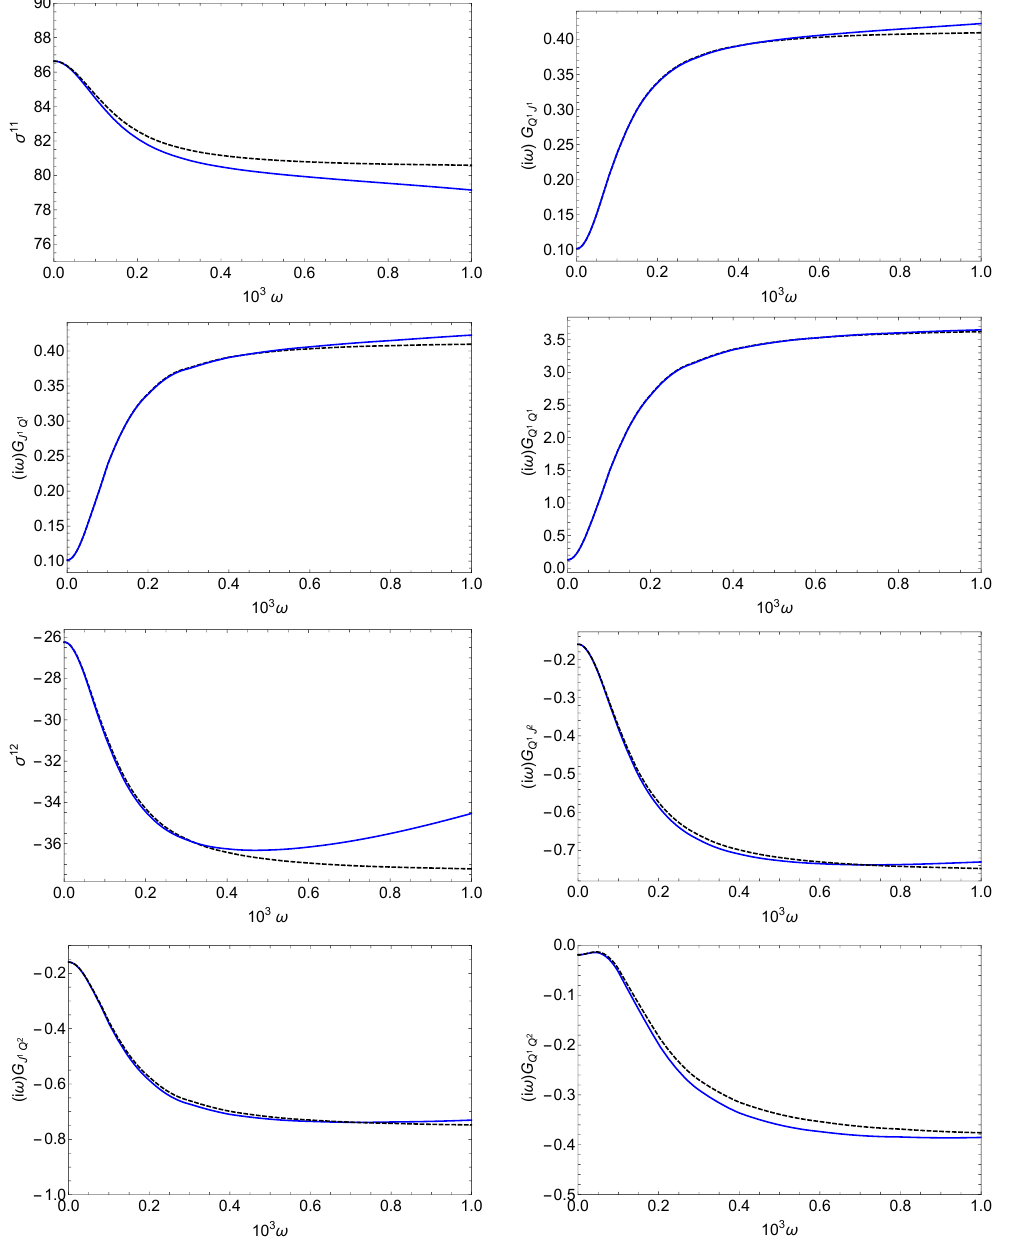
Figure 4 . Plots of the components (1 , 1) and (1 , 2) of the thermoelectric conductivities as functions of the frequency. The dashed lines correspond to the analytic formulas (3.38). Here (cid:0) (cid:1) ( φ s , ψ s , T, µ, k, k s , γ, δ, B ) = 10 − 4 , 4 , 1 , 1 , 3 , 3 , 3 , 1 , 1 . 100 20 10 2 100 Interestingly, we have shown that apart from the gap, the magnetic field causes the corre- sponding poles to move off the imaginary axis due to resonance effects. In section 3.4 we computed the retarded Green’s functions of the operators relevant to the hydrodynamic description of the system. As one might expect, the poles due to pinning have a direct effect on the transport properties of our system as can be seen from the explicit form of the Green’s functions in equation